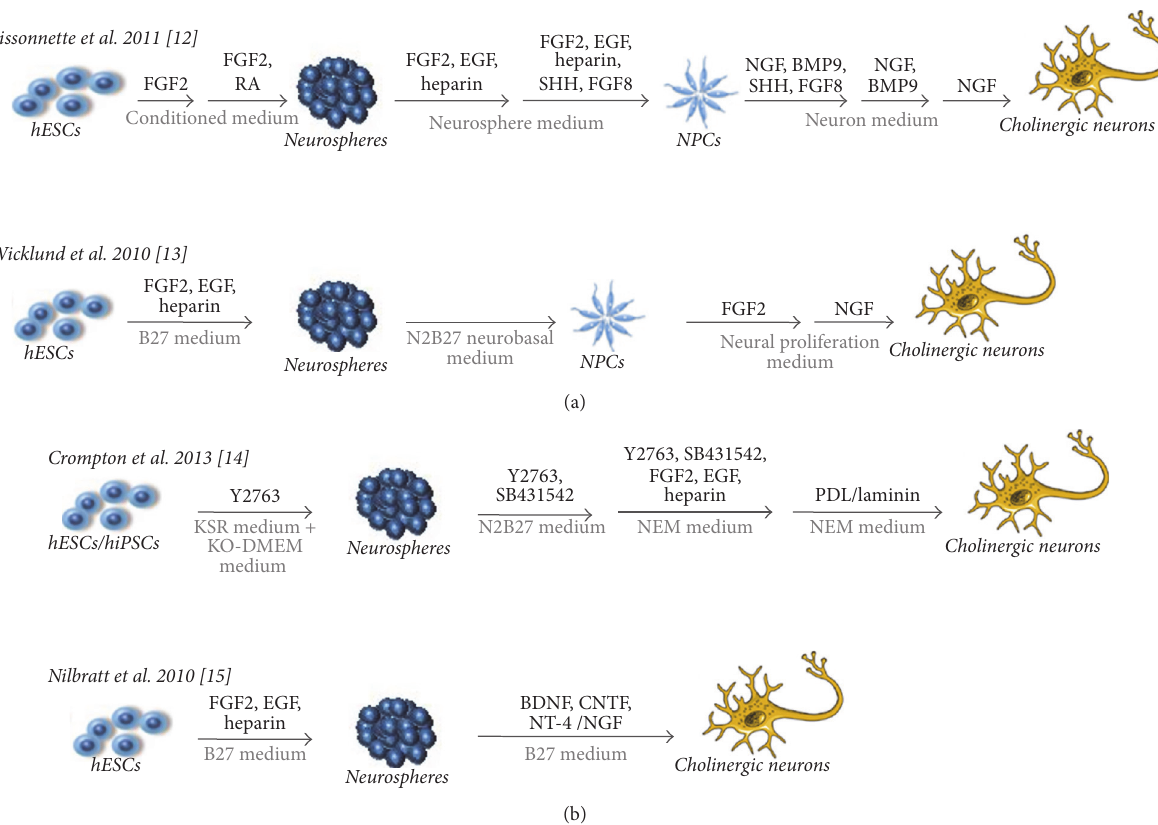
Figure 2: Comparison of different protocols for deriving of basal forebrain cholinergic neurons from hESCs and hiPSCs. (a) Generation of BFCNs from neurospheres through neural progenitor cell stage. Predominantly pure population of basal forebrain cholinergic neurons (BFCNs) was derived from hPSCs by using diffusible ligands presented in the forebrain during a development [12]. Pretreatment with SHH and FGF8 was used to differentiate hPSCs towards a forebrain progenitor fate [12]. Treatment with NGF promoted the differentiation into functionally mature BFCNs [12, 13]. (b) Direct generation of BFCNs from cells growing in neurospheres. Neural development was induced in neurosphere-based nonadherent differentiation in presence of mitogens and ROCK inhibitor Y27632 [14]. Neurospheres derived from hPSCs exposed to neurotrophins, BDNF, CNTF, NT-4, and NGF, increased neuronal differentiation and cholinergic phenotype specification [15]. Composition of the basic medium can be different within the above